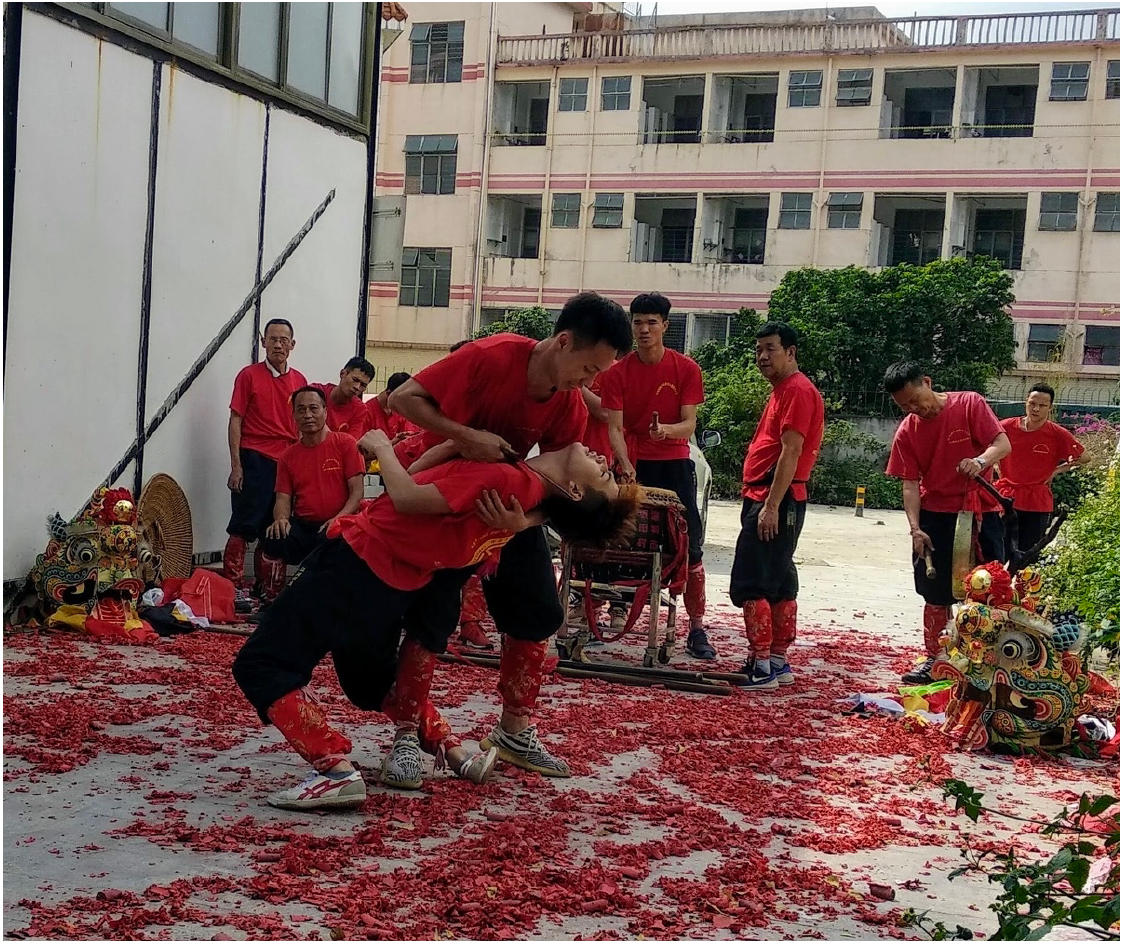
Figure 3 Hakka traditional martial